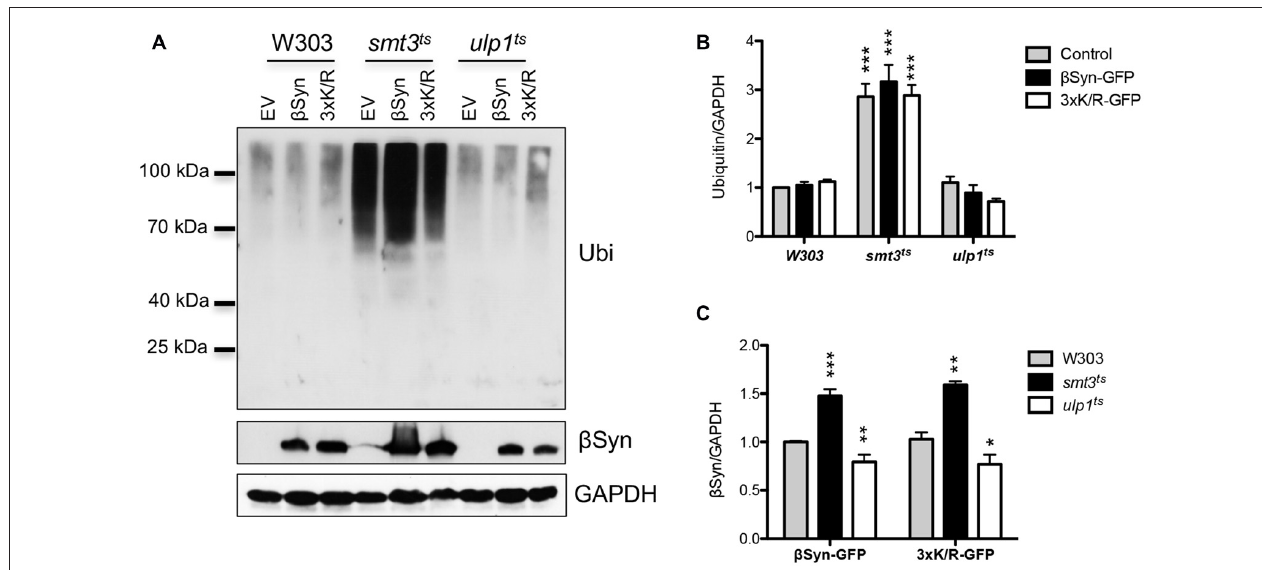
FIGURE 7 | Interplay between sumoylation and ubiquitination. (A) Western blot analysis of crude protein extracts from yeast cell, expressing β Syn-GFP and 3xK/R-GFP mutant in W303, smt3 ts and ulp1 ts strains at 30 ◦ C, probed with ubiquitin antibody, detecting poly- and mono-ubiquitinated proteins. The same membrane was stripped and probed with β Syn antibody. GAPDH was used as a loading control. (B) Densitometric analysis of the immunodetection of ubiquitin or β Syn (C) , relative to the GAPDH loading control. Significance of differences was calculated with t -test ( ∗∗∗ p < 0.001; ∗∗ p < 0.01; ∗ p < 0.05 vs. W303 wild type background; n = 3).